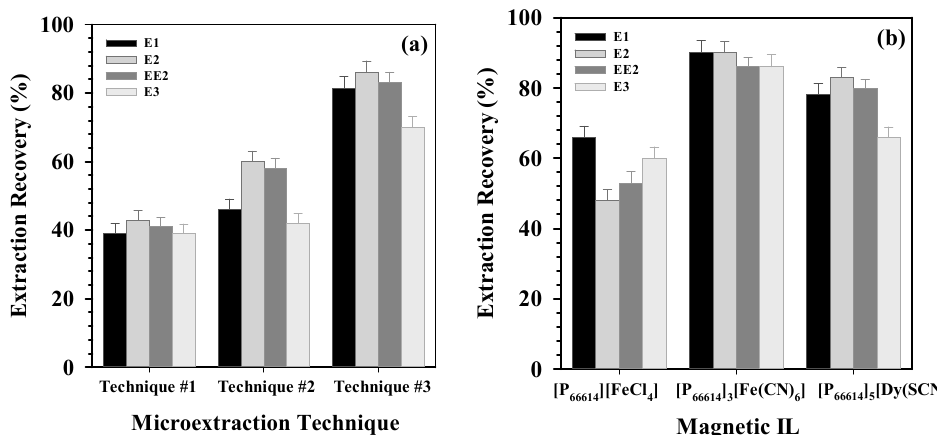
Figure 2. Effect of ( a ) different magnetic-based microextraction techniques and ( b ) different MILs on extraction recoveries of E1, E2, EE2, and E3, ( n = 3). Other experimental conditions are included in Table 4.